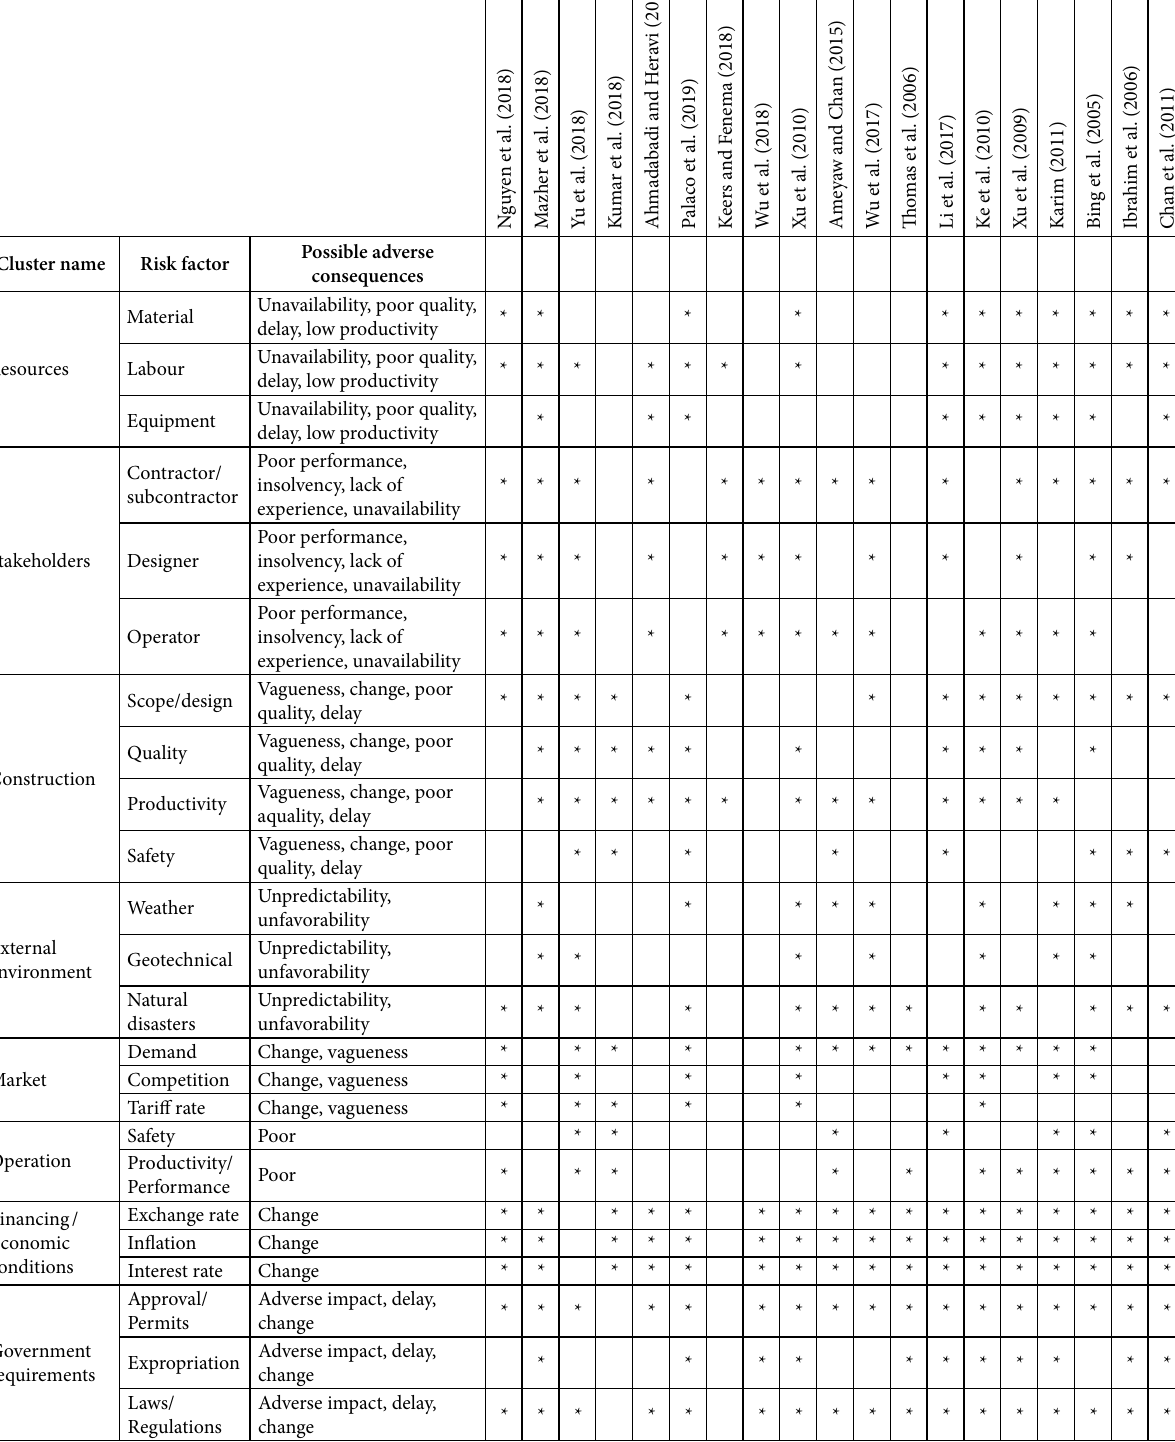
Table 2. Risk factors of PPP hydropower